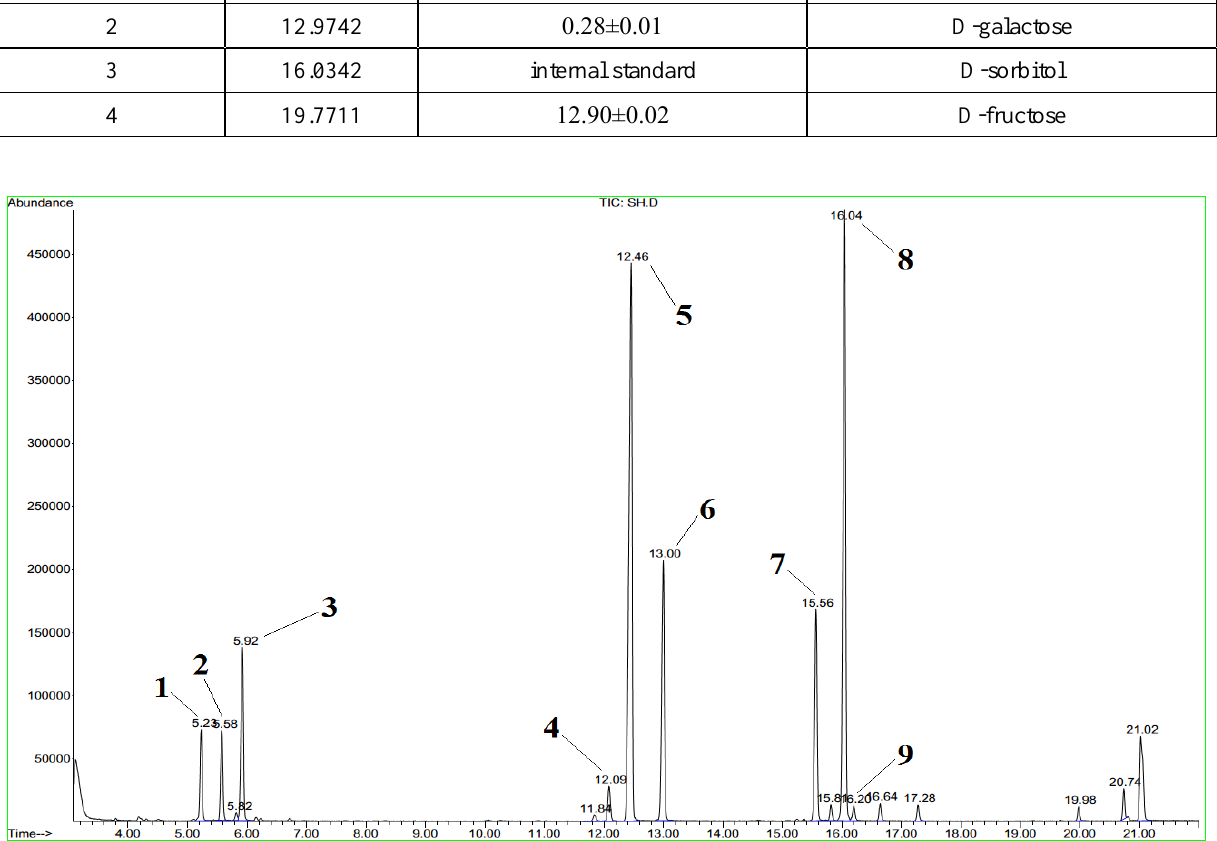
Fig. 4. GC/MS chromatogram of monosaccharides and their derivatives after hydrolysis in Agrimonia eupatoria L. herb The results of monosaccharides and their derivatives after hydrolysis in Agrimonia eupatoria L. herb. Peak on